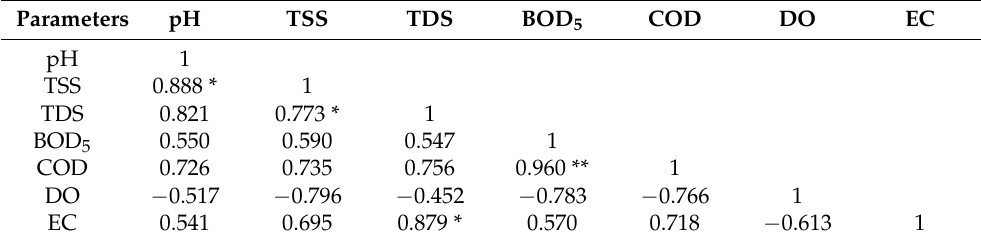
Table 4. Pearson’s correlation coefficients among the physicochemical parameters in the Dhaleshwari River (significance of correlation was measured both at 0.01 and 05 levels).